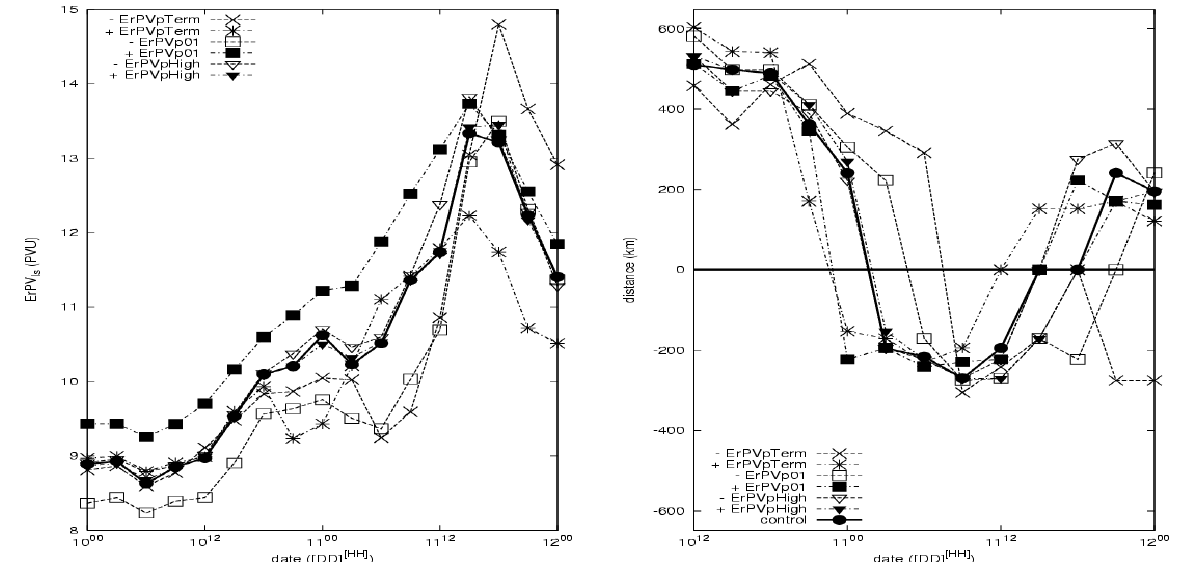
Fig. 13. Labels as in Fig. 11, but left panel: evolution of the C0 central value (PVU). Right panel: Evolution of the relative distance (km) between C0 and cyclone, positive(negative) sign denotes eastward(westward) relative position of the cyclone (starting date on 10 November at